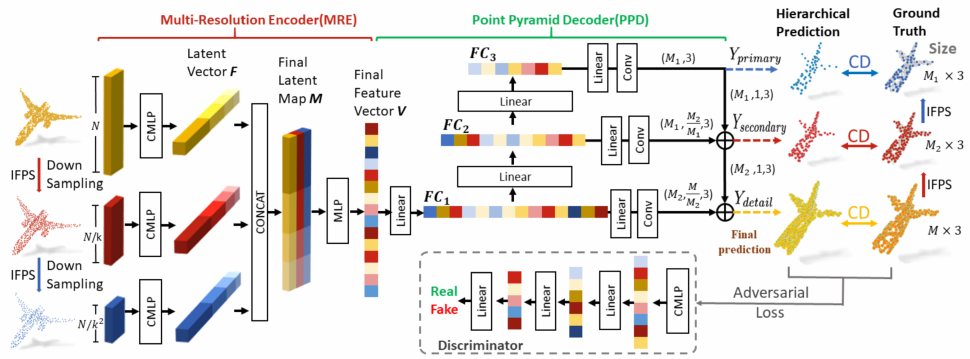
Figure 21. Point Fractal Network [129] architecture.